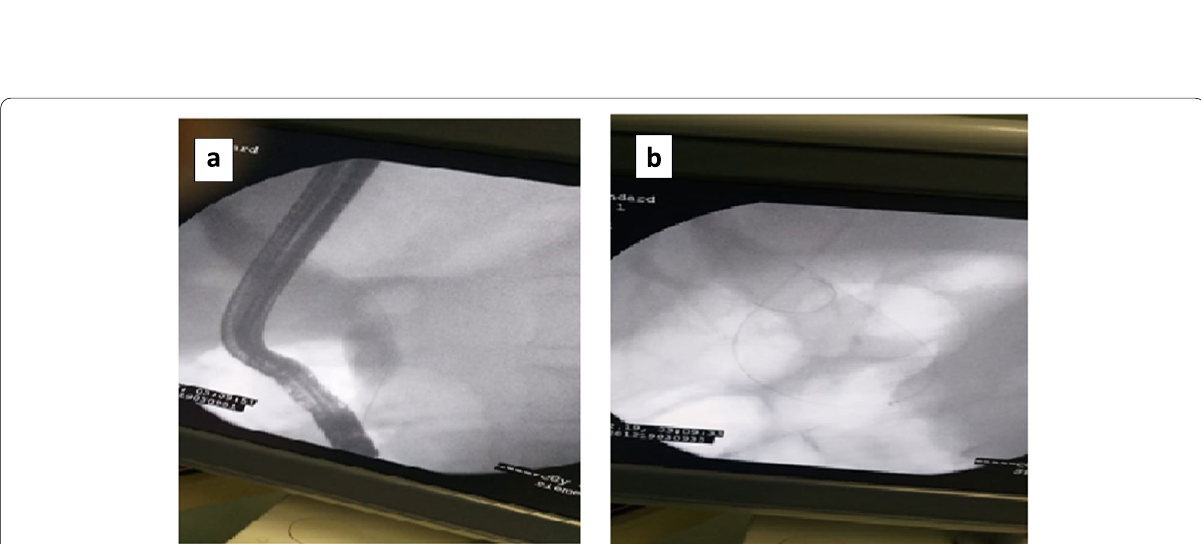
Fig. 3 a The migrated up inflated balloon in the CBD. b The migrated up balloon in the CBD after removal of